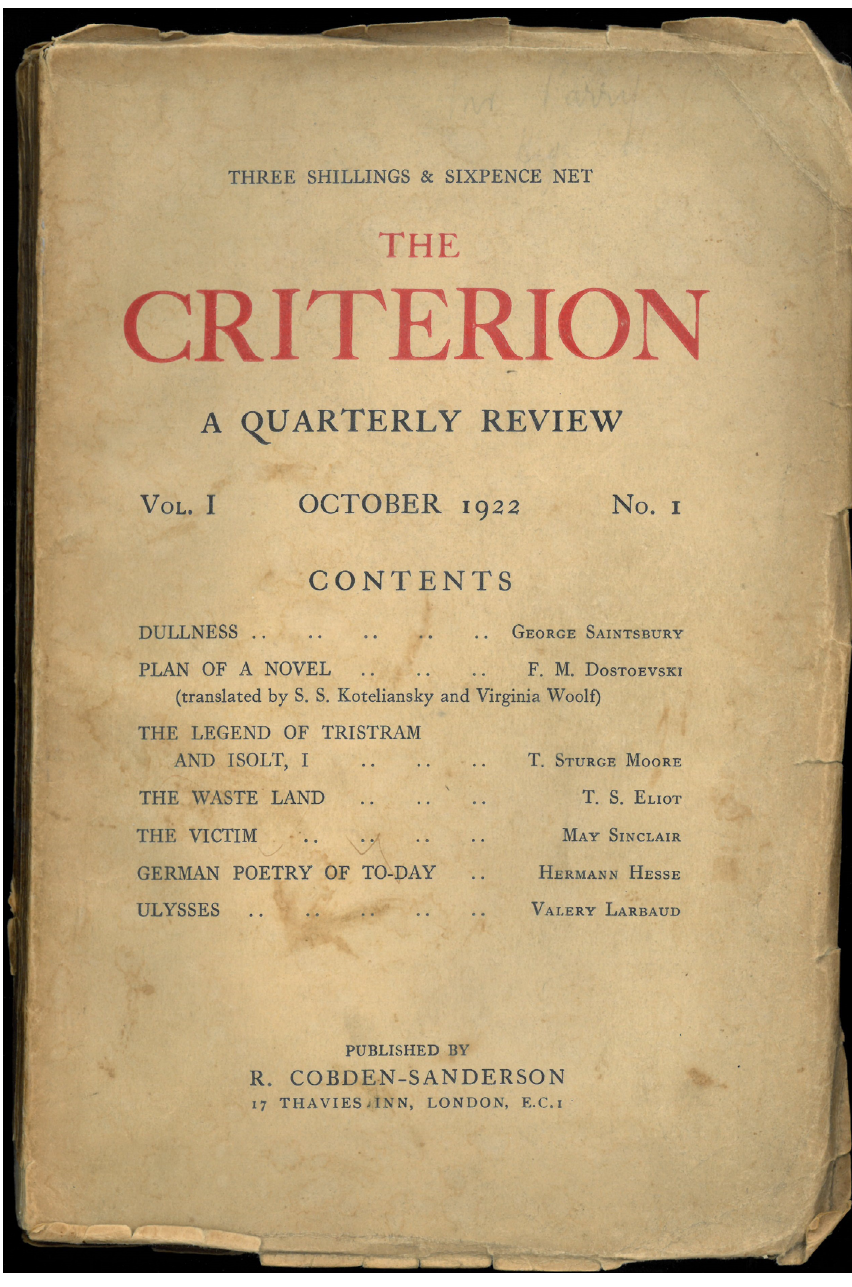
Fig. 1 Cover of the first Criterion